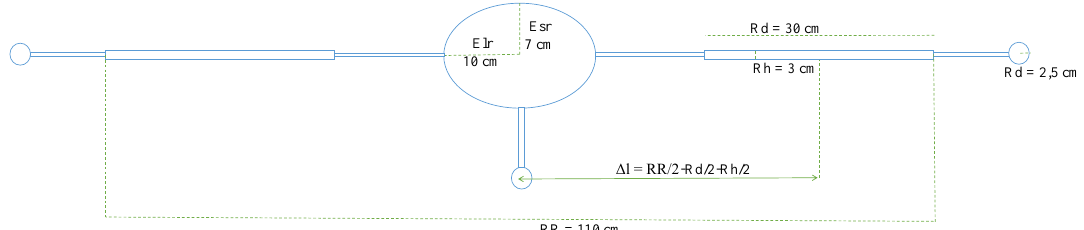
Figure 2. The side-sketch of the virtual drone prototype.